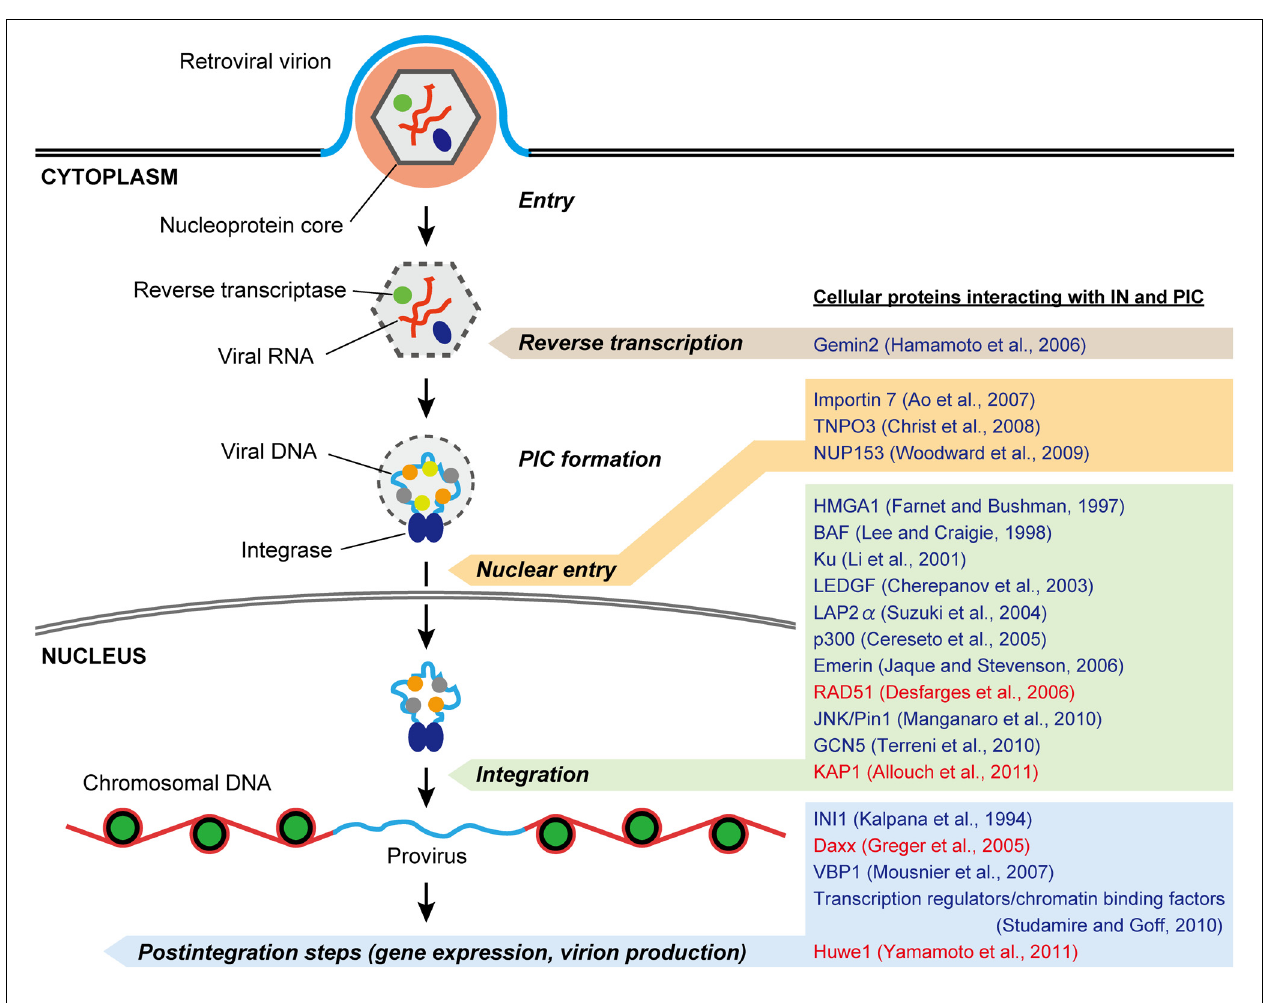
interphase. In the nucleus, the PIC gains access to chromosomal DNA and mediates viral DNA integration to produce a provirus, which is acted upon by viral and/or cellular transcription factors to express viral RNAs.To date, a number of host proteins have been reported to interact with the retroviral IN and PIC (representative proteins are listed on the right). Many of them are likely to assist in the integration step, and some other cofactors appear to have functional roles in other steps including reverse transcription, nuclear entry, gene expression, and virion production during virus infection. In addition, recent studies demonstrate that several cellular interactors of IN may negatively regulate retrovirus replication (highlighted in